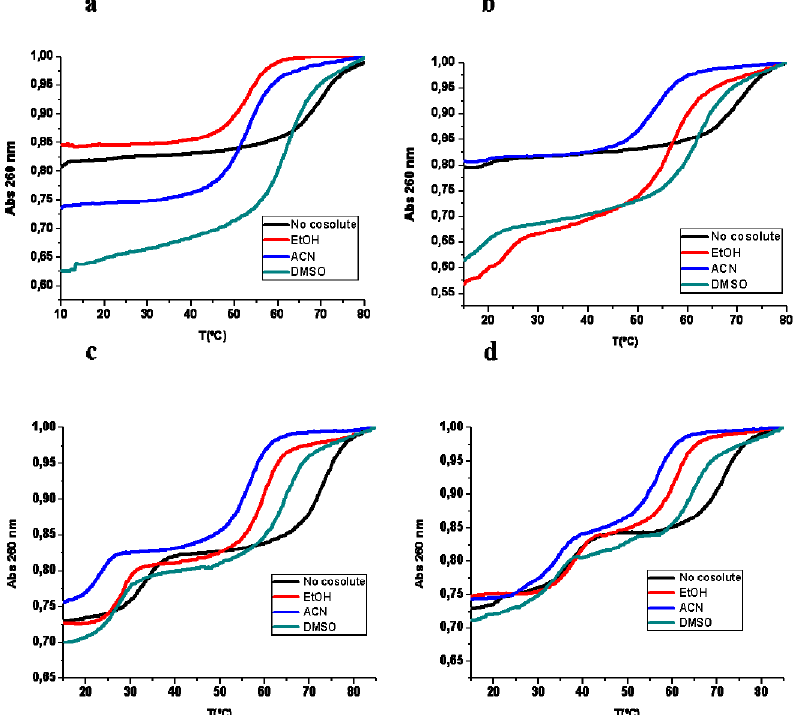
Figure 1. Normalized melting curves of triplexes formed by hairpin sequences with the corresponding DNA and RNA TFOs. ( a ) hairpin 1 and DNA TFO 1; ( b ) hairpin 1 and RNA TFO 1; ( c ) hairpin 2 and DNA TFO 2; ( d ) hairpin 2 and RNA TFO 2 in the presence of 20% ( v/w ) of cosolutes, 10 mM phosphate buffer 100 mM NaCl pH 6.